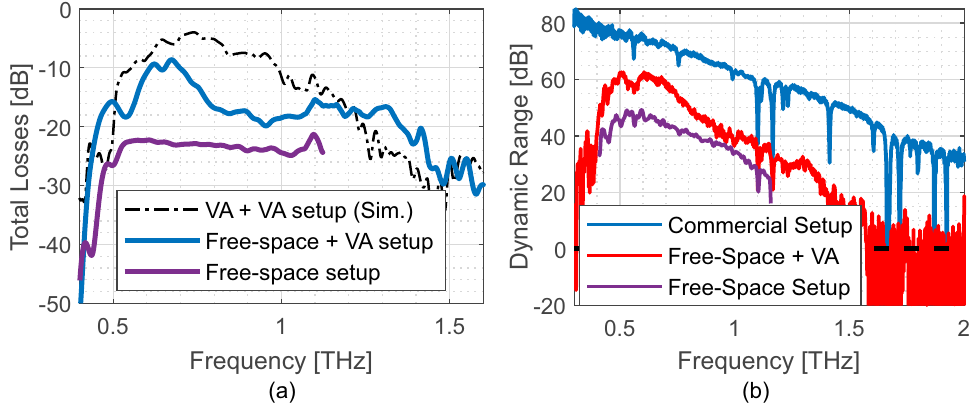
Figure 6. ( a ) shows the total losses of the semi-free-space measurement setup shown in Figure 5c. The measured losses are averaged over 25 GHz. ( b ) shows the dynamic range comparison